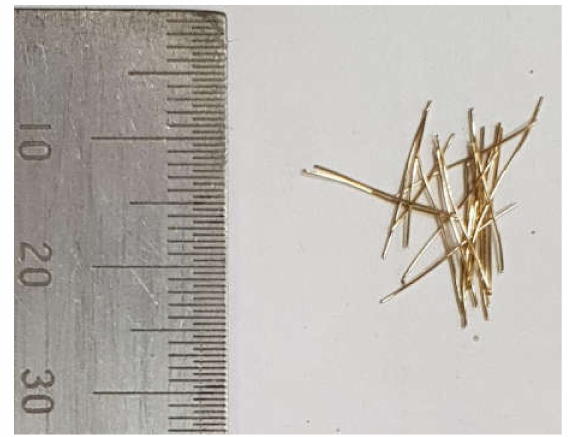
Figure 2. The straight-end fibres used in this